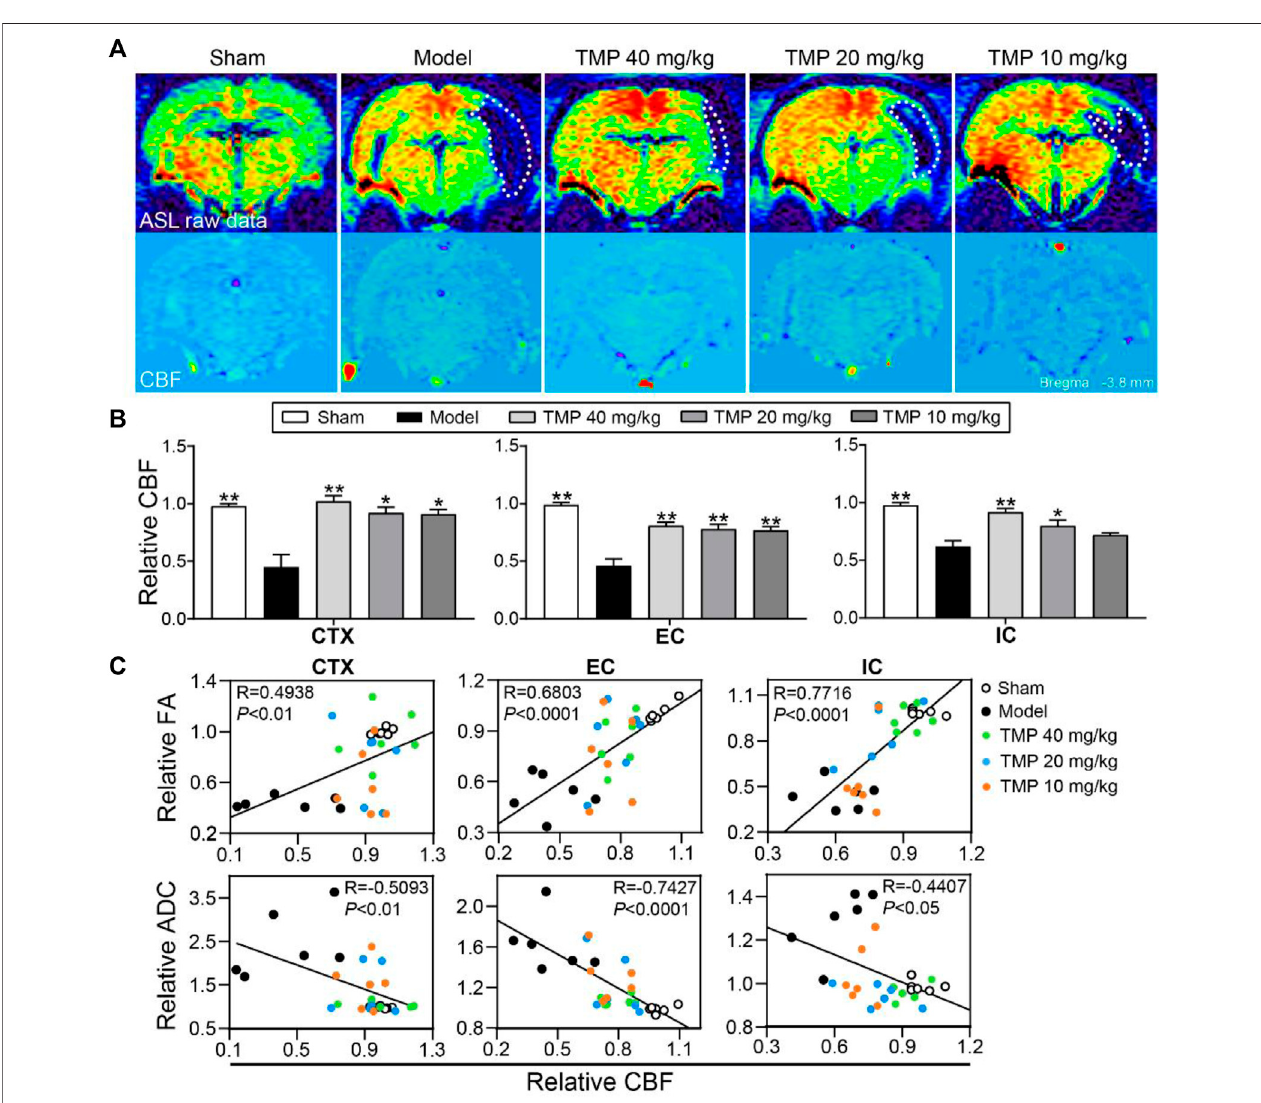
FIGURE 5 | Effect of TMP on cerebral perfusion in MCAO rats. (A) Typical ASL raw data and CBF images of each group. The ischemic areas are represented with whitedottedlines( n =6). (B) Quantitation ofrelativeCBF(rCBF)oftheperi-infarctcortex(CTX),externalcapsule(EC),andinternalcapsule(IC). (C) Correlationsbetween DTI metrics (rFA and rADC) and rCBF of CTX, EC, and IC. * p < 0.05 and ** p < 0.01 vs. Model group.